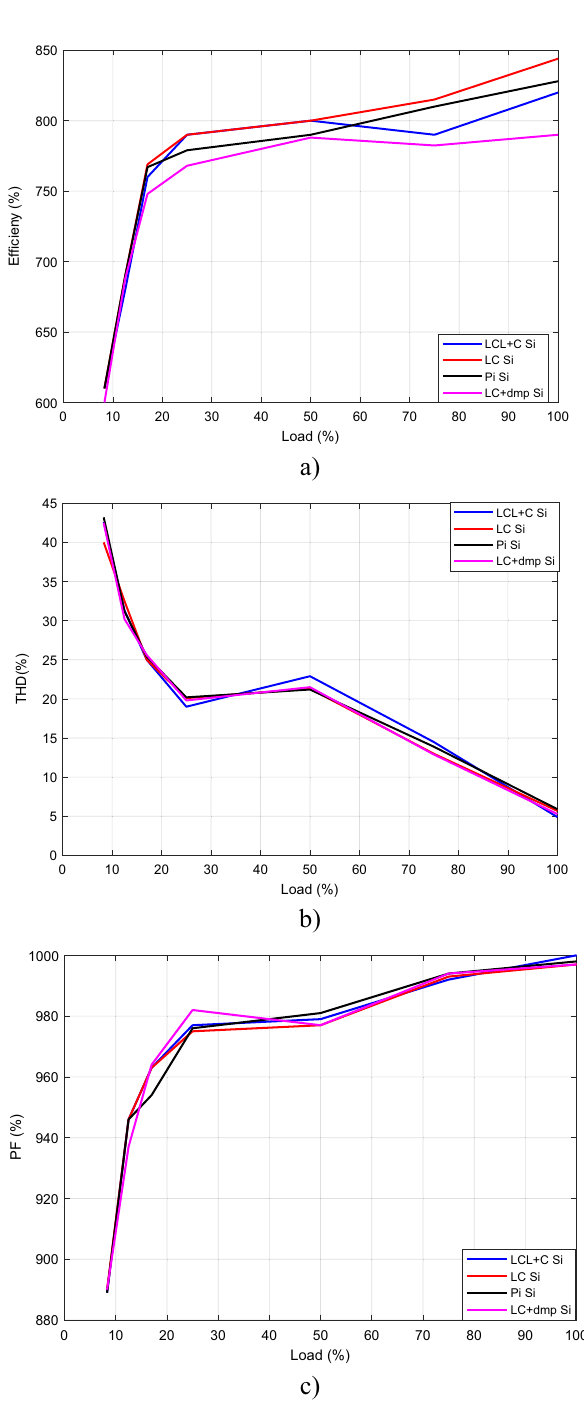
Figure 39. ( a ) Efficiency, ( b ) THD, ( c ) PF for Si Mosfet by load change.